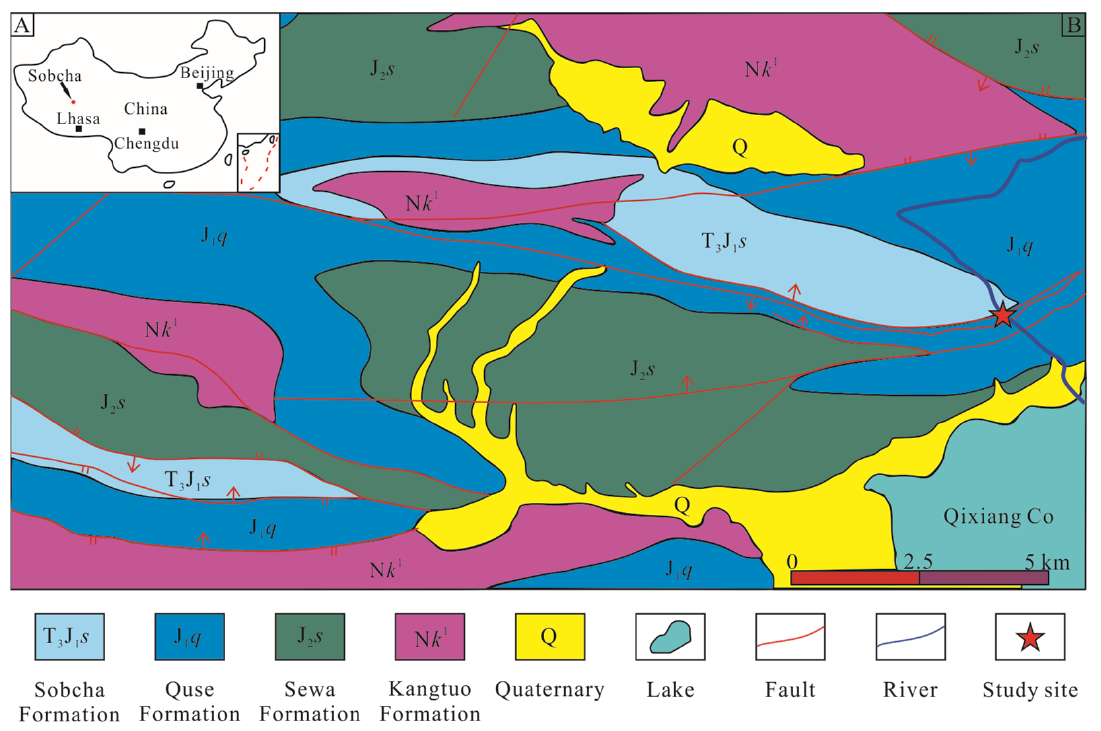
Figure 1. ( A ) The location of Sobcha in the Tibetan Plateau, southwestern China. ( B ) Simplified geological map of the study area (modified from Fu et al. [70] ).